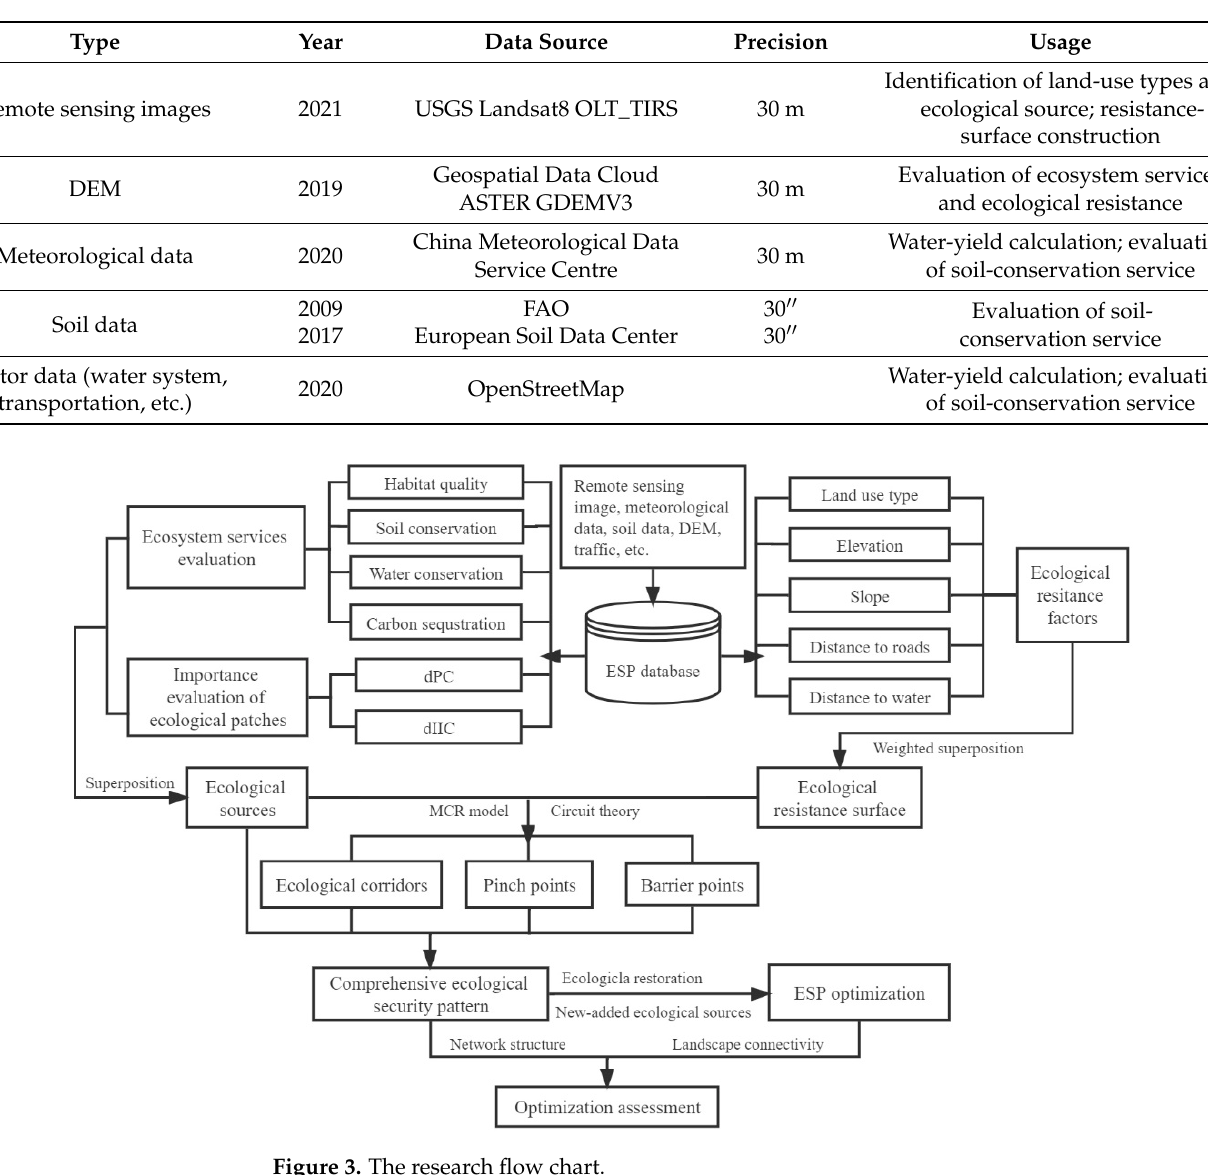
Table 1. Basic data.